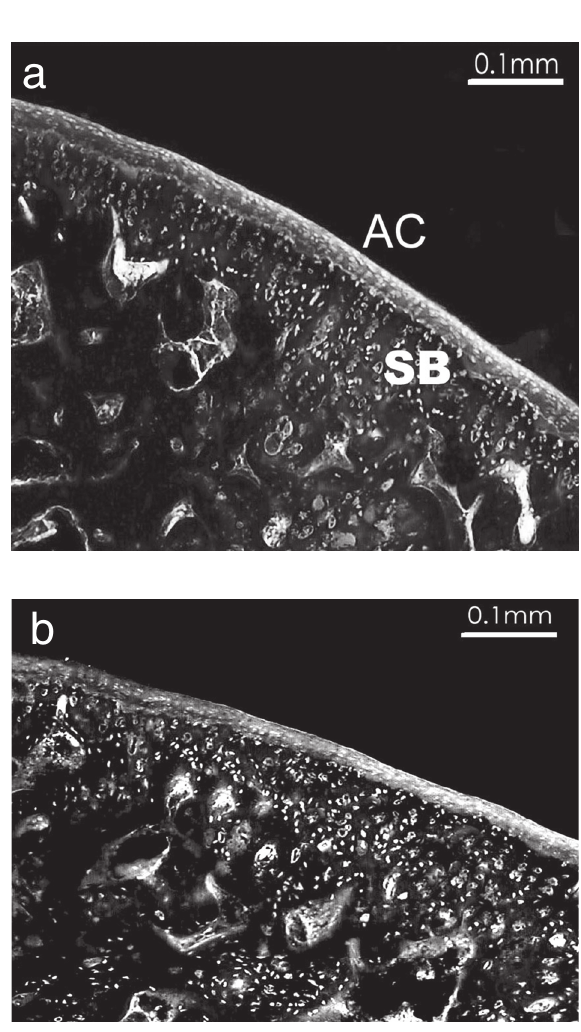
Figure 1. Frontal plane sections of the femoral head visualized under ultraviolet light with fluorescence of the newly formed bone (clear areas) given by tetracycline labeling. A, Representative section of animals from control I, control II, and suspended groups. The femoral head is spherical and the femoral neck is well-defined; the ossific nucleus (ON), growth plate (GP) and cancellous bone (CB) have normal configuration. a, Details show the normal microscopic anatomy of the articular cartilage (AC) and subchondral bone (SB). B, Representative section from an animal belonging to the suspended-released group: there is flattening of the femoral head, misshaping of the femoral neck, decreased height of the ossific nucleus, and partial closure of the growth plate (arrow). b, Details show thinning of the articular cartilage and distortion of the subchondral bone. C, In the sus- pended-trained group, the femoral head has a normal shape and bone microarchitecture. There is growth plate interruption (ar- row) and sparing of the ossific